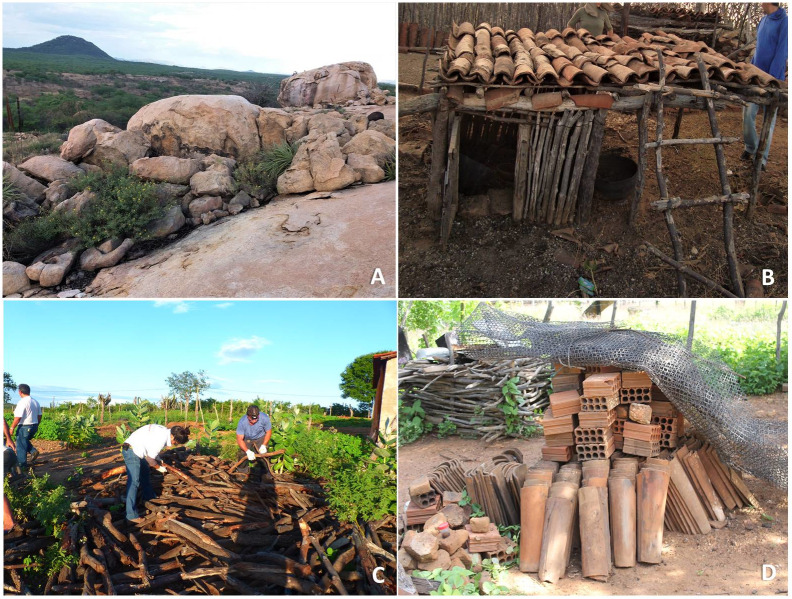
Ecotopes where Triatoma brasiliensis is found.A) natural habitat (the primary ecotope), represented by rocky outcrops. The artificial habitats are: B) breeding places for livestock; C) woodpiles, used for wood-fired ovens; and D) piles of the material of mineral origin (tiles, bricks and stones), used mainly for building constructions.